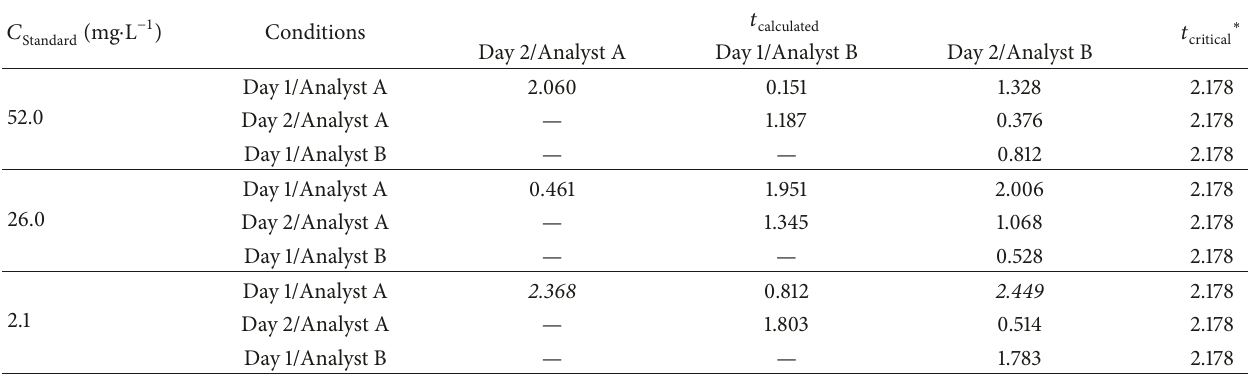
Table 3: Student’s t -test to the mean data in the evaluation of the repeatability and intermediate precision.